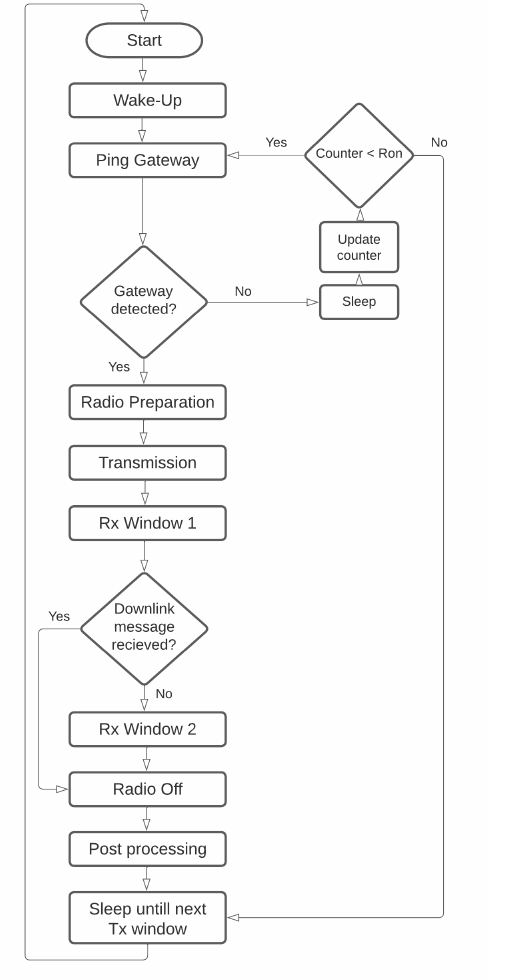
Figure 6. End-node procedure in semisynchronized and nonsynchronized